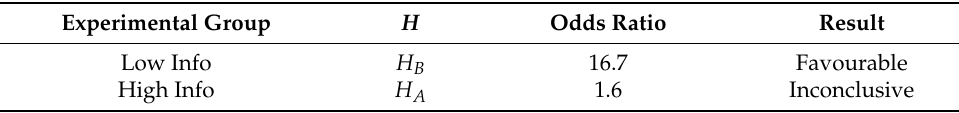
Table 6. δ ’s sensitivity to considering extreme asks.